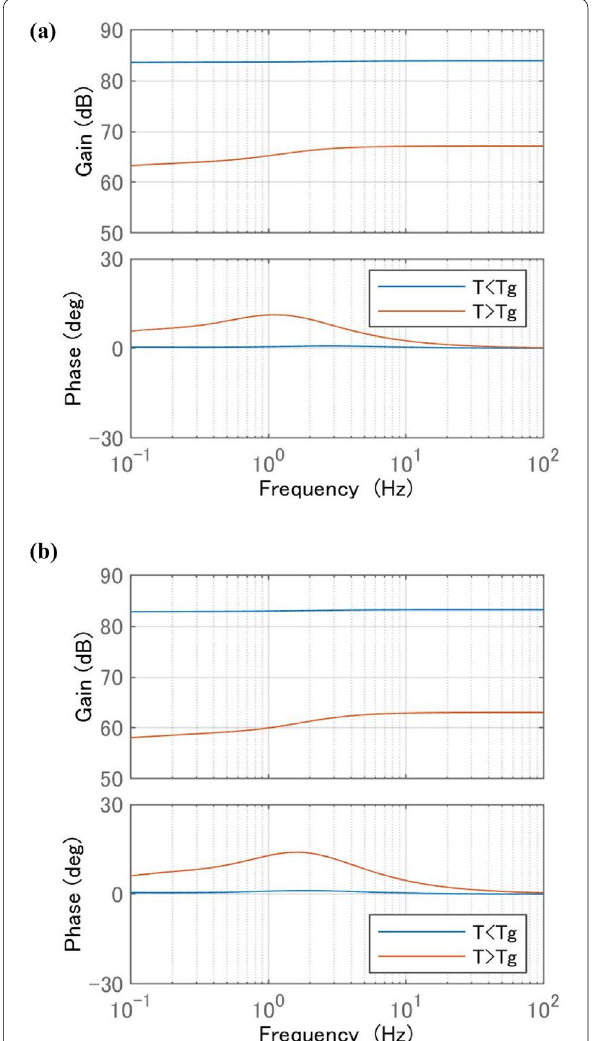
Fig. 14 Frequency responses of transfer function obtained using Method 1. a #1. b